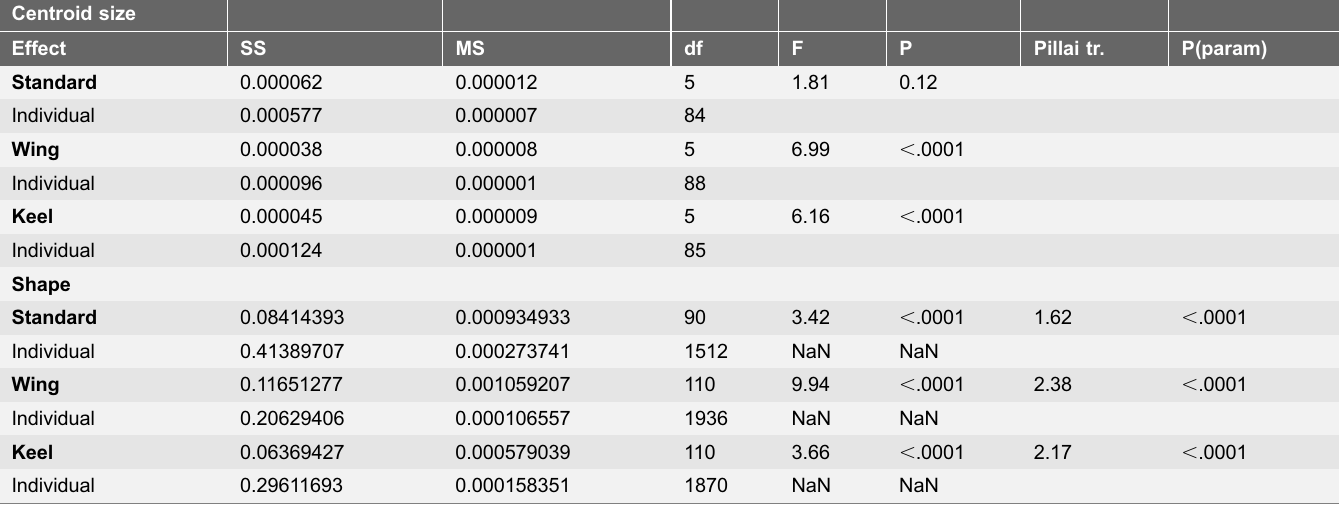
Table 2. Procrustes ANOVA for both centroid size and shape of the Sophora lines. Centroid size